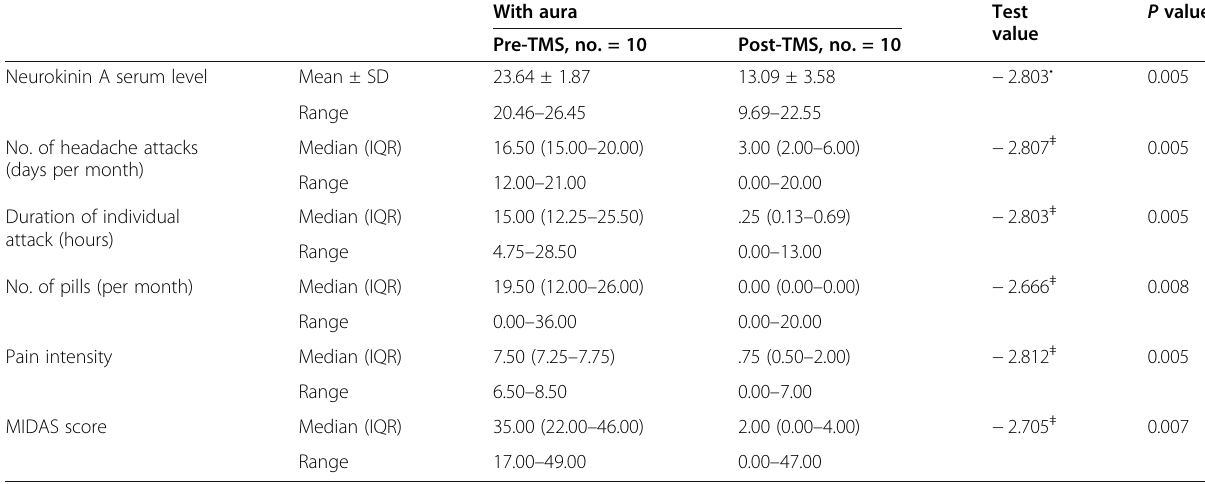
Table 4 Comparison between 4 weeks pre- and 4 weeks post-TMS as regards clinical data of migraine, MIDAS, and serum levels of neurokinin A in group B (migraine with aura) With